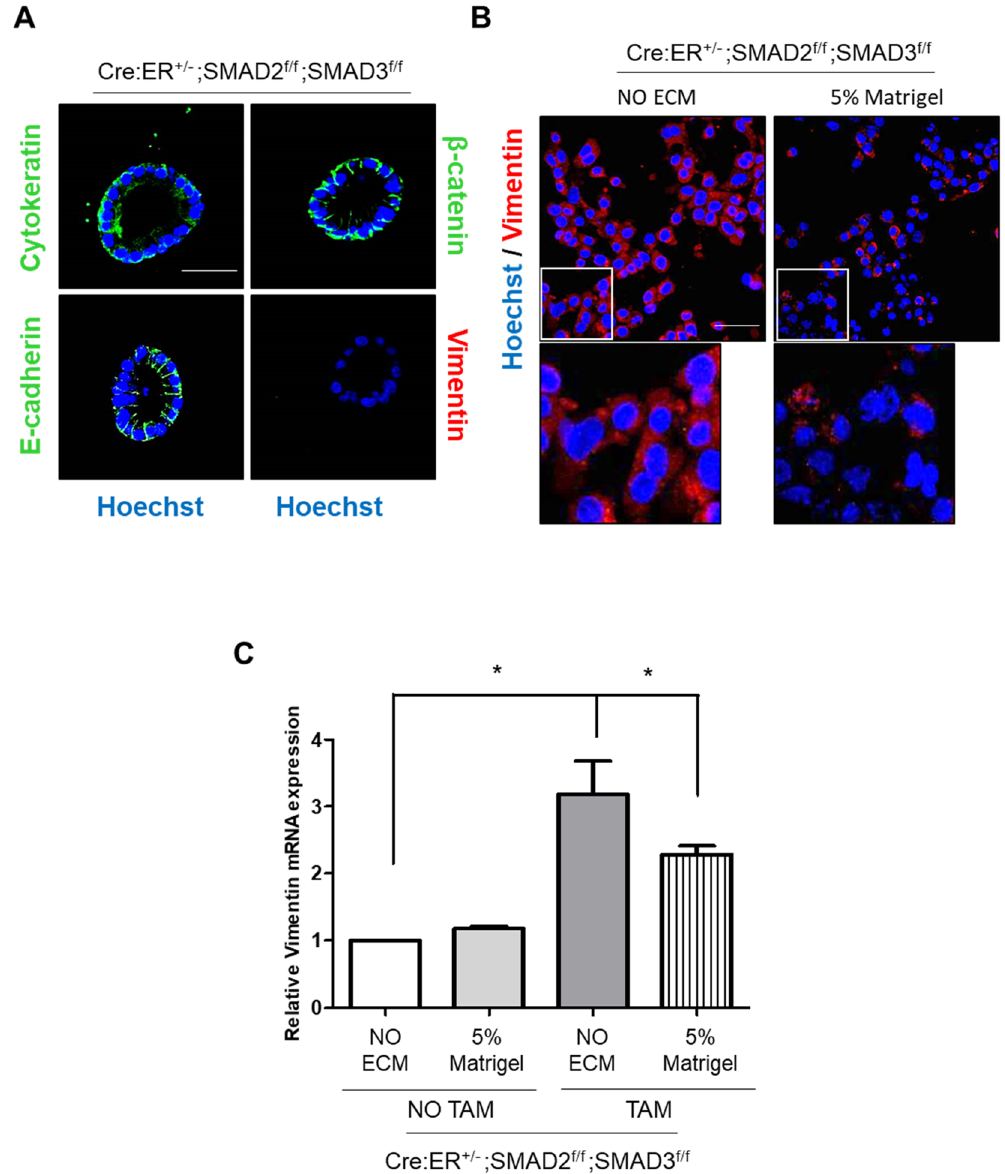
Figure 9. ( A ) Representative confocal images cytokeratin, E-cadherin, β-catenin and vimentin, on 3D organoid cultures from Cre:ER +/− ; SMAD2 f/f ; SMAD3 f/f endometrial epithelial cells treated with tamoxifen to induce SMAD2/3 deletion. Scale bars: 25 µm. ( B ) Immunofluorescence corresponding to 2D endometrial epithelial monolayers isolated from Cre:ER +/− ; SMAD2 f/f ; SMAD3 f/f , plated and treated with tamoxifen (TAM) to induce Cre:ER-mediated deletion of SMAD2 and SMAD3 alleles then treated for 72 h with 5% Matrigel diluted in basal culture medium or left untreated (NO ECM). Images were captured after 3 days of tamoxifen-induced deletion. Cells were counterstained with Hoechst to visualize nuclei. Scale bars: 25 µm. ( C ) RT-qPCR relative quantification of vimentin mRNA expression of 2D endometrial epithelial monolayers isolated from Cre:ER +/− ; SMAD2 f/f ; SMAD3 f/f . Cells were plated and treated (TAM) or not (NO TAM) with tamoxifen to induce Cre:ER- mediated deletion of SMAD2 and SMAD3 alleles, then treated for 72 h with 5% Matrigel diluted in basal culture medium or left untreated (NO ECM). Results are expressed as mRNA expression relative to untreated (NO ECM). Values are mean ± S.E.M. * P < 0.01, by t test